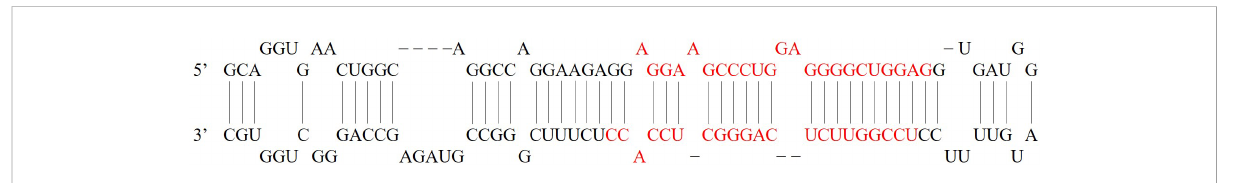
FIGURE 2 pre-miR-671 stem-loop structure (7). The red sequence is the mature miRNA. miR-671-5p: 29-AGGAAGCCCUGGAGGGGCUGGAG-51. miR- 671-3p: